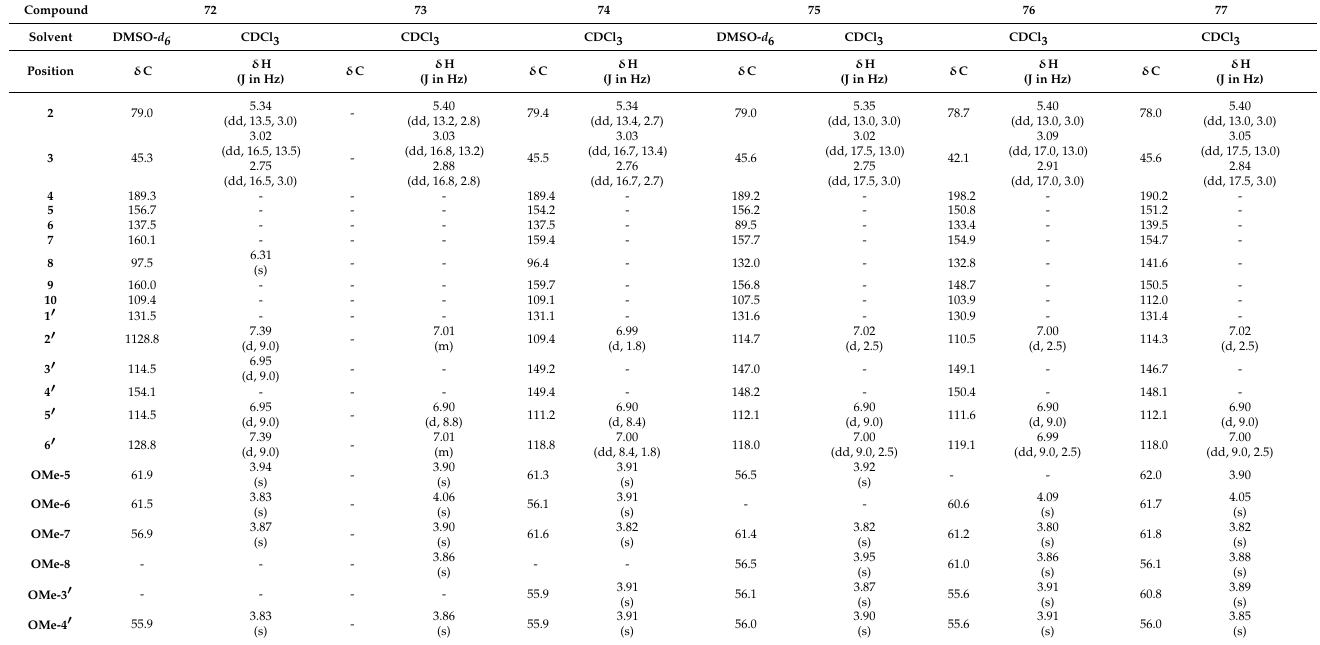
Table 13. 1 H-NMR and 13 C-NMR of polymethoxyflavanones’ ( 72 – 77 ) skeleton isolated in Citrus genus.